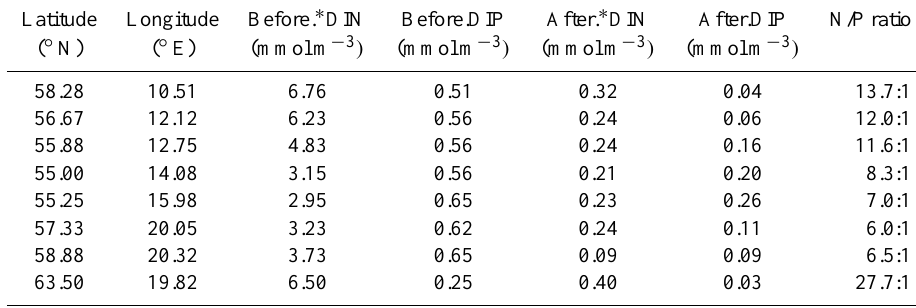
Table 2. N/P ratio of nutrient alteration before and after spring blooms in surface waters. Latitude Longitude Before. ∗ DIN Before.DIP After. ∗ DIN After.DIP N/P